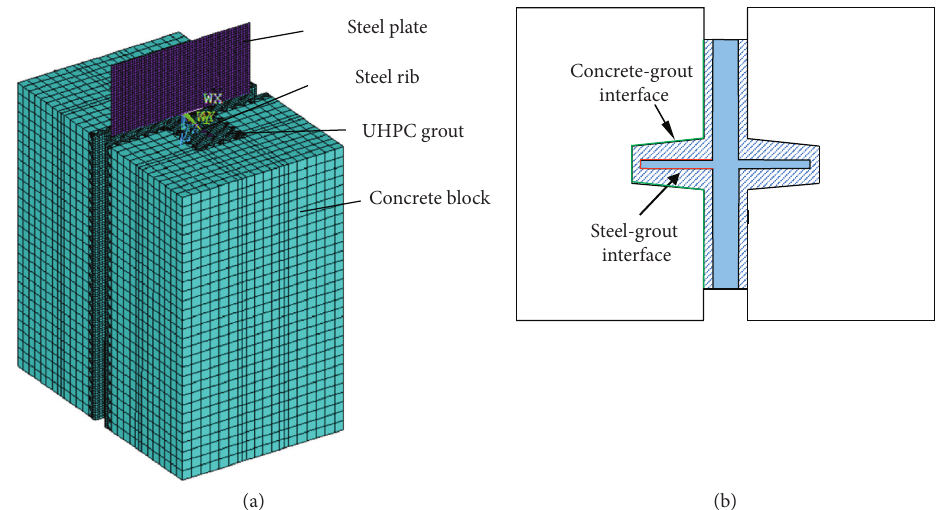
Figure 17: FE model of push-out test specimen. (a) 3D view. (b) Plane